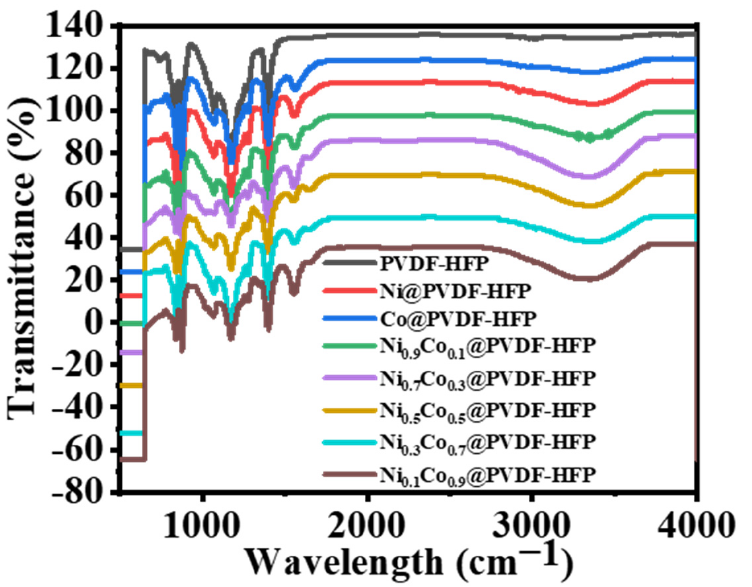
Figure 5. FTIR analysis of PVDF ‐ co ‐ HFP, Ni@PVDF ‐ co ‐ HFP, Co@PVDF ‐ co ‐ HFB, and Ni 0.3 Co 0.7 @PVDF ‐ co ‐ HFP NF membranes.